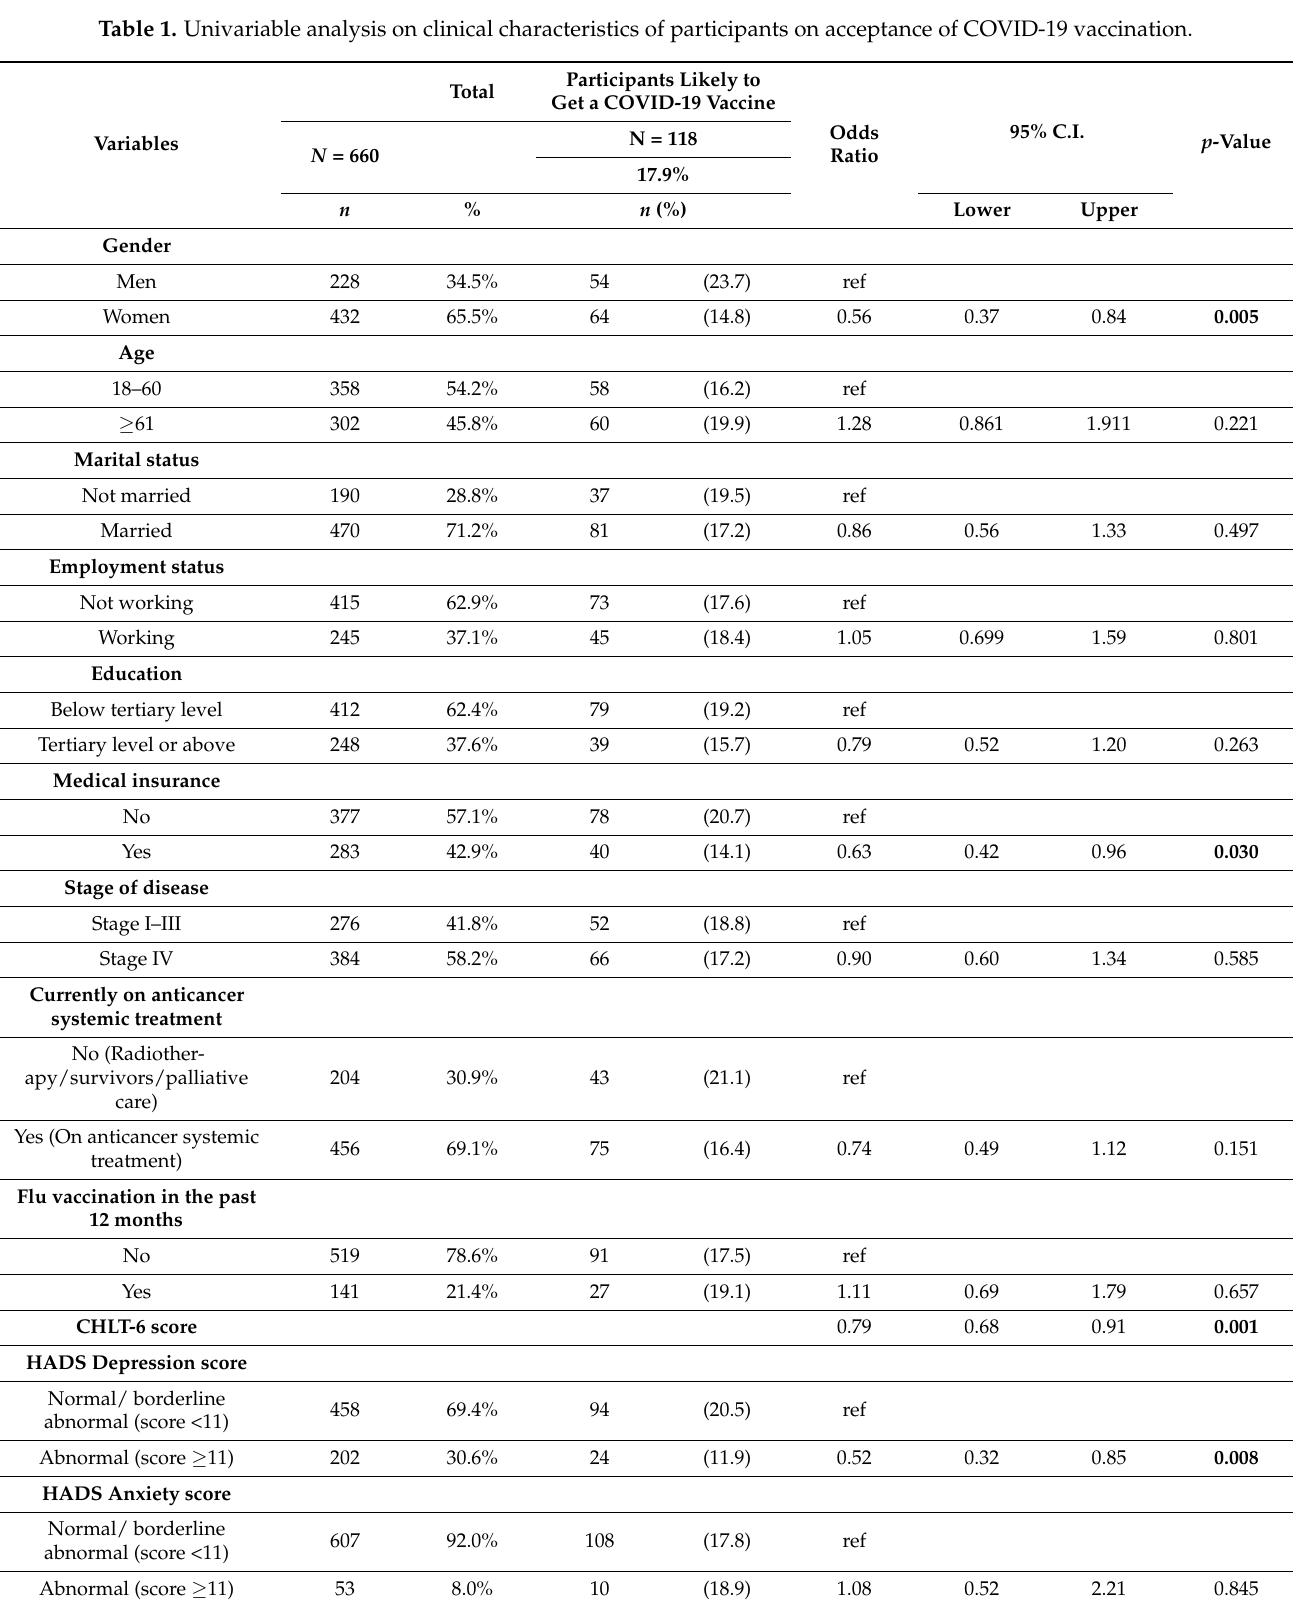
Table 1. Univariable analysis on clinical characteristics of participants on acceptance of COVID-19 vaccination.